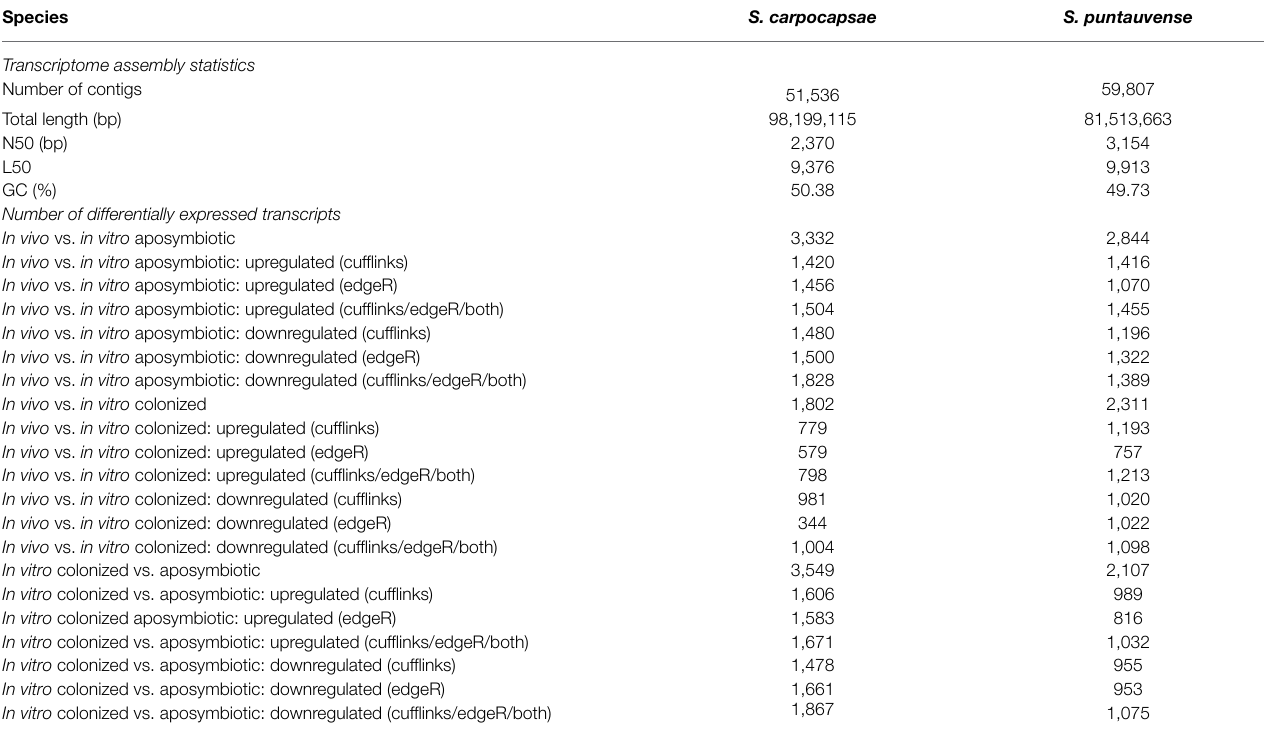
TABLE 1 | Statistical summary of transcriptome assemblies and number of differentially expressed transcripts in in vitro (colonized and aposymbiotic) and in vivo Steinernema carpocapsae and Steinernema puntauvense IJs.